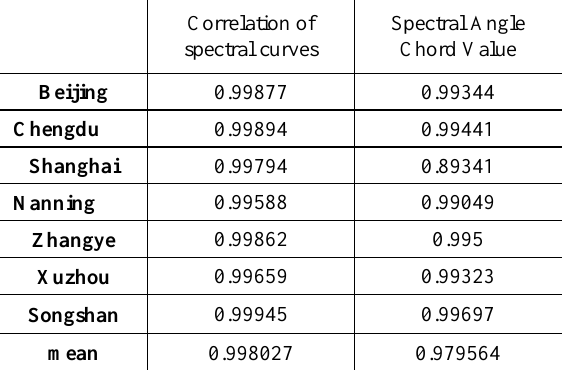
Table 3 . Correlation and spectral cosine angle of continuous spectral curve of ZY1-02D reflectance product